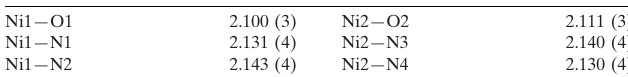
Selected bond lengths (A˚ ).